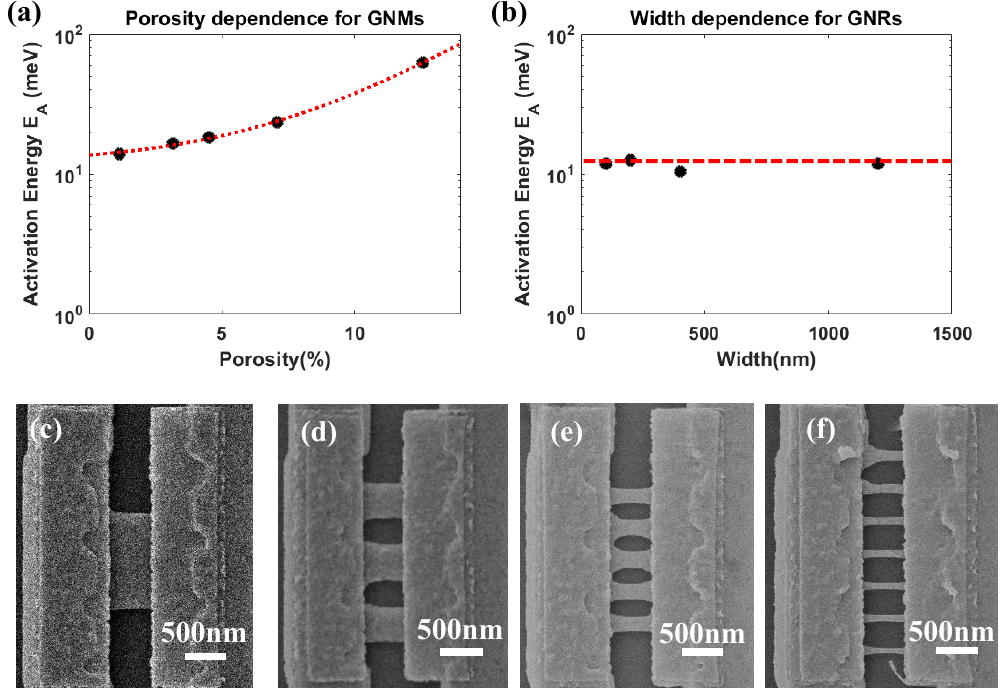
Figure 12. ( a ) The extracted activation energies for the GNM devices with different porosities. The black dots were the experimental data. The red dot line was the exponential fitting. ( b ) The extracted activation energies for the GNR devices with different width. The black dots were the experimental data. The red dot line was the linear fitting. ( c ) One GNR with 1200 nm width and 500 nm length. ( d ) Three GNRs with 400 nm width and 500 nm length. ( e ) Five GNRs with 200 nm width and 500 nm length. ( f ) Seven GNRs with 100 nm width and 500 nm length.